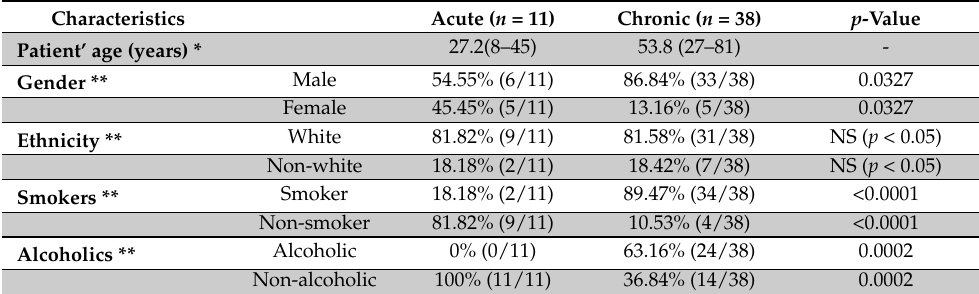
Table 2. Sociodemographic characteristics and relevant clinical parameters of patients treated in The Medical School of Botucatu (FMB) of S ã o Paulo State University (UNESP), Botucatu, from 2004 through 2014 and